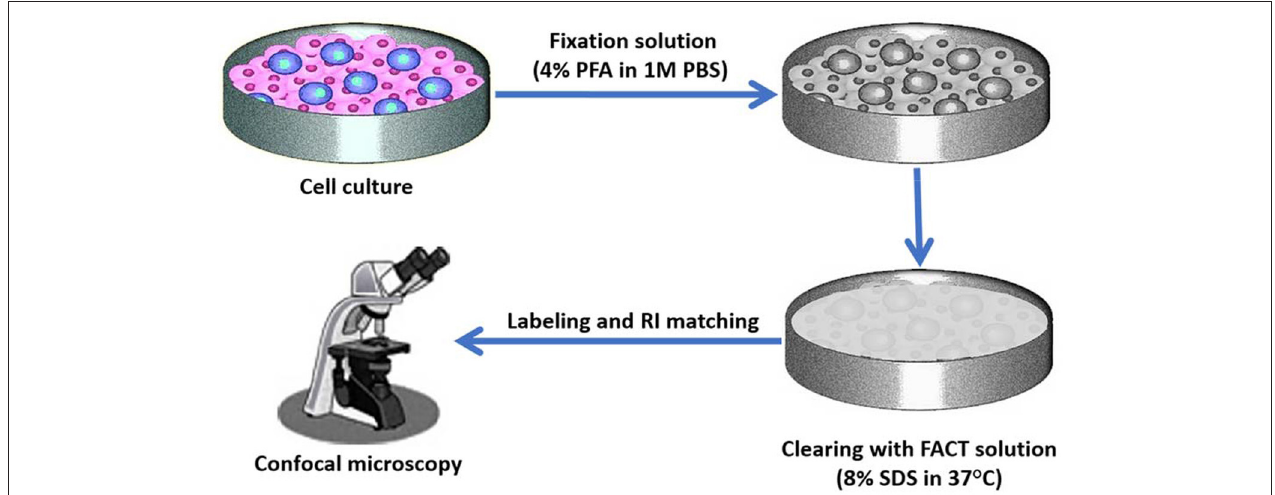
FIGURE 4 | Cell culture three-dimensional (3D) imaging with the FACT method. Target labeled cells will be cultured in a traditional culture medium. After confluency of cells, they can be fixed in 4% paraformaldehyde (PFA) in phosphate buffer saline (PBS). After cell fixation, clearing FACT solution containing 4% SDS can be added and dishes can be shaken at 37 ◦ C. The cells then can be washed with PBS and after refractive index (RI) matching, 3D imaging can be performed by confocal microscope.